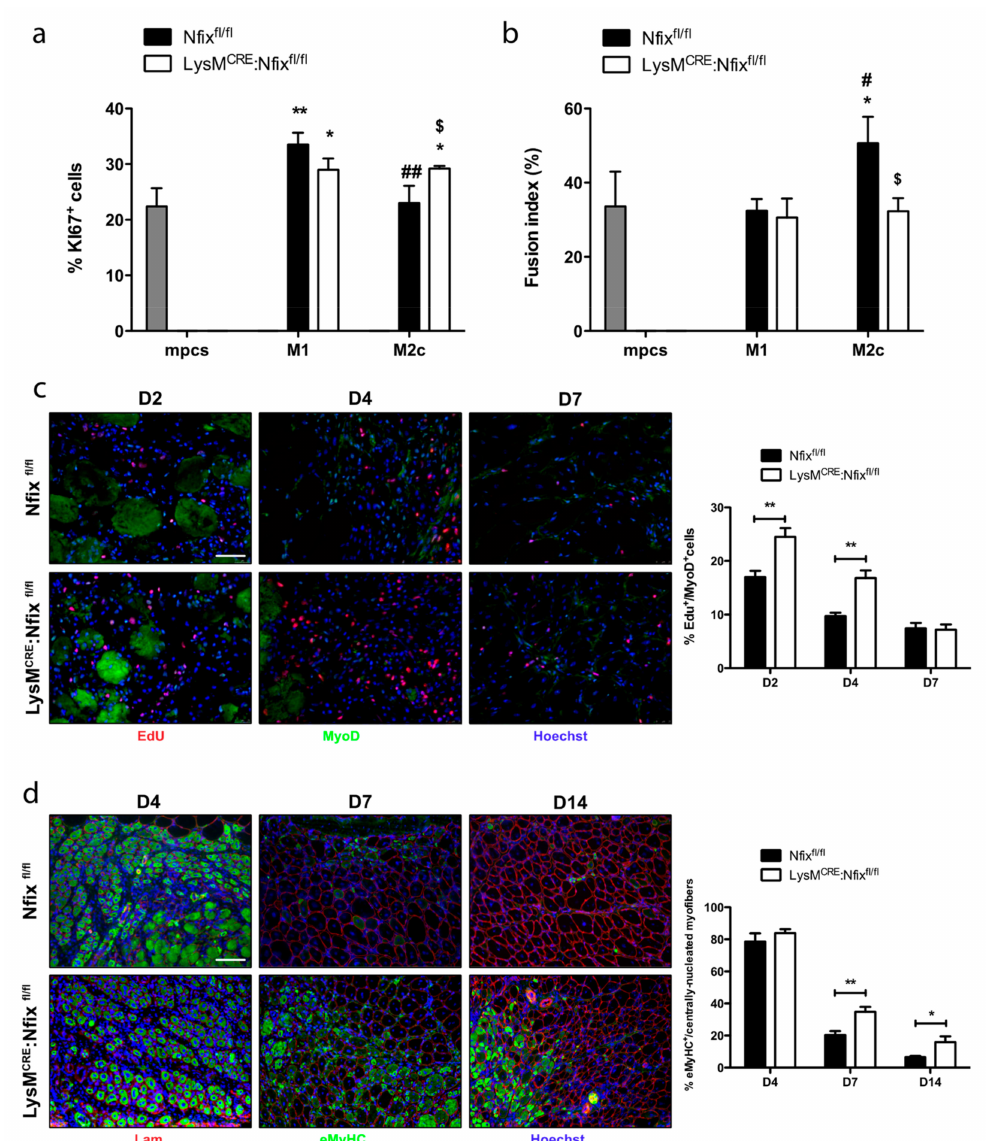
Figure 4. M2 MPs lacking Nfix display M1 MP features on myoblasts in vitro and in vivo. ( a ) Conditioned medium of M1 or M2c polarized Nfix fl / fl and LysM CRE :Nfix fl / fl BMDM was added on mpcs, and after 24 h, mpc proliferation was measured as a percentage of Ki67 + cells; ( b ) Conditioned medium of M1 or M2c polarized Nfix fl / fl and LysM CRE :Nfix fl / fl BMDM was added on mpcs and after 72 h, mpcs fusion index was calculated after sarcomeric MyHC staining (% of MyHC + nuclei into myotubes out of the total nuclei). * p < 0.05, ** p < 0.01 vs. mpcs. # p < 0.05, ## p < 0.01 versus M1 Nfix fl / fl . $ p < 0.05 versus same Nfix fl / fl polarization; ( c ) Immunostaining for EdU (red), MyoD (green) and Hoechst (blue) of Nfix fl / fl and LysM CRE :Nfix fl / fl TA injected by CTX, at D2, D4 and D7 post-injury and quantification of EdU + / MyoD + cells. EdU was injected in Nfix fl / fl and LysM CRE :Nfix fl / fl mice 8 h before sacrifice; ( d ) Immunostaining for Lam (red), eMyHC (green) and Hoechst (blue) of Nfix fl / fl and LysM CRE :Nfix fl / fl TA injected by CTX, at D4, D7 and D14 post-injury and quantification of eMyHC + / centrally-nucleated myofibers. * p < 0.05, ** p < 0.01 Results are means ± SEM of at least three independent experiments. Scale bar = 50 µ